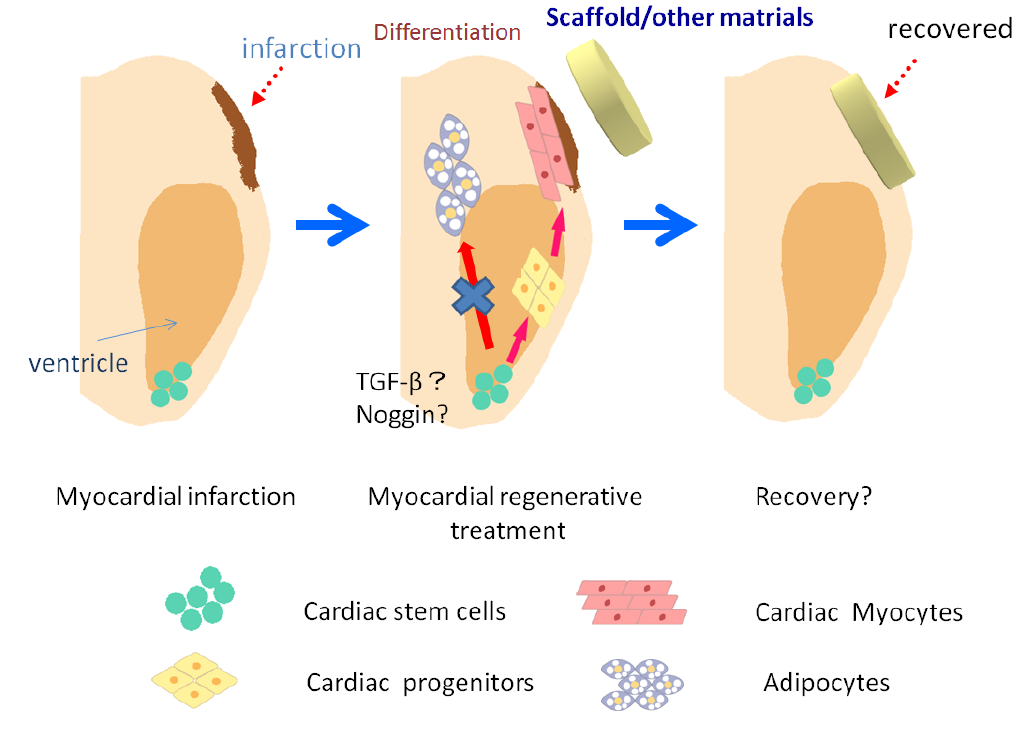
Figure 2. The concept of regenerative medicine. Endogenous cardiac stem cells (CSCs) are expected to differentiate into cardiac progenitors and/or cardiomyocytes, but not to other cell types such as adipocytes in the presence of cytokines, e.g., TGF- (cid:533)(cid:3) (cid:68)(cid:81)(cid:71)(cid:3) (cid:81)(cid:82)(cid:74)(cid:74)(cid:76)(cid:81)(cid:17)(cid:3) (cid:55)(cid:75)(cid:72)(cid:3) CSCs can also be used as a material for transplantation with scaffold or other materials. Materials with or without CSCs that release cytokines for cardiomyocyte survival